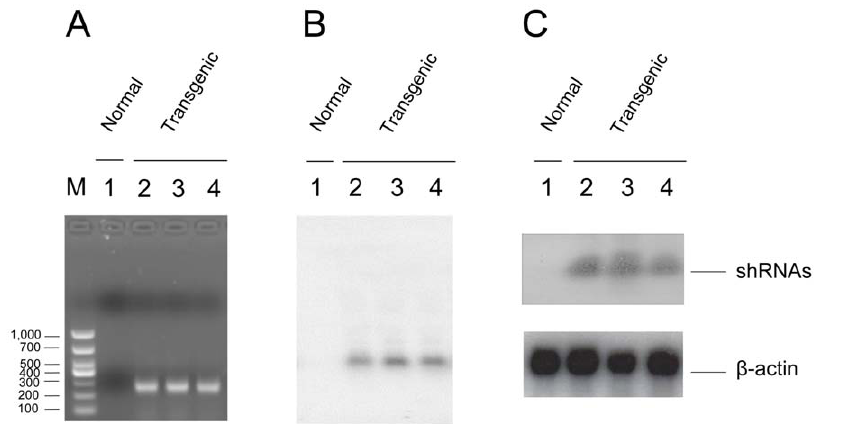
Figure 4. shRNA integration into chromosome of cloned fetuses and expression in primary transgenic bovine tongue epithelium cells. The genomic DNA from the ear tissue of one normal (lane 1) and three transgenic (lane 2, 3, and 4) fetuses were extracted, and used as the template for PCR amplification, there was positive band in cloned fetuses, but not in normal fetus (A), shRNA transgenic fragment was confirmed by DNA sequencing. The genomic DNAs then were digested into smaller fragments with excess amounts of Xho I and Apa I for Southern Blotting, and were hybridized with probe (B). The expression of shRNA in primary transgenic bovine tongue epithelium cells was determined by Northern analyses (C), b -actin as a quantitative controls. Three experiments were independently repeated.